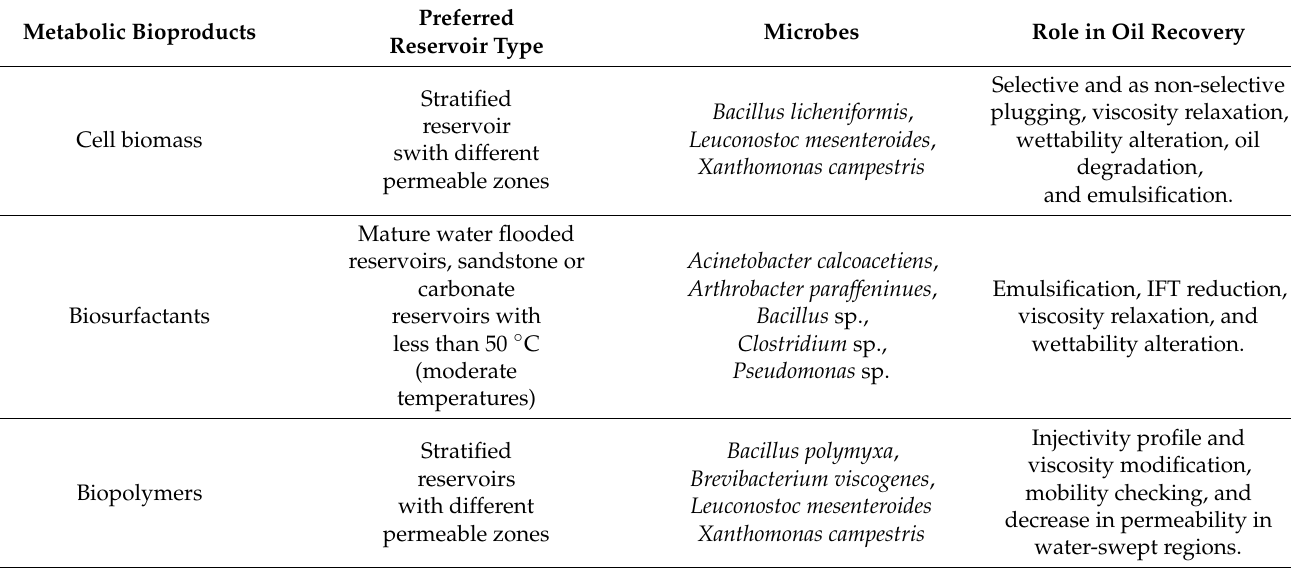
Table 1. Various microbial metabolic products and their uses